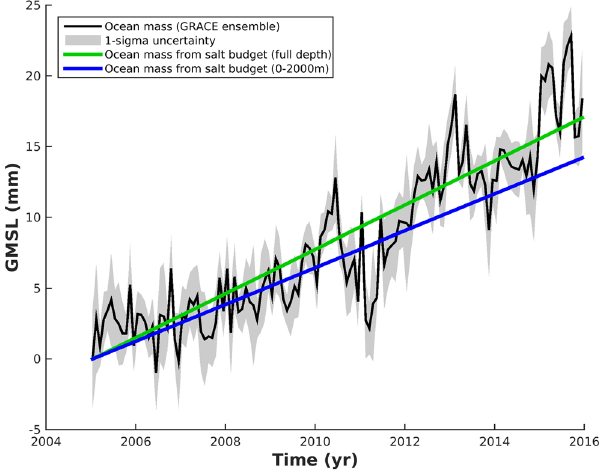
Figure 3. Ocean mass contribution to global mean sea level. Ocean mass change inferred from GRACE data (black curve) and from the global ocean freshening (blue and green curves for the 0–2000 m and full depth, respectively). Seasonal signals have been removed from the GRACE curve. Shading denotes 1- σ uncertainty of the respective estimates. Curves are offset for